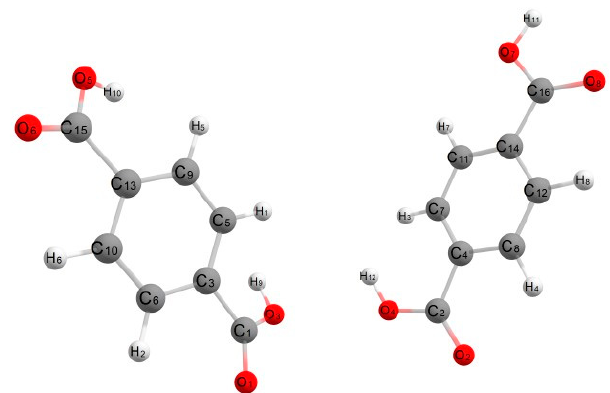
Figure 13. The periodic structure of bulk UiO-66 and the optimized structure of the UiO-66 linker model.